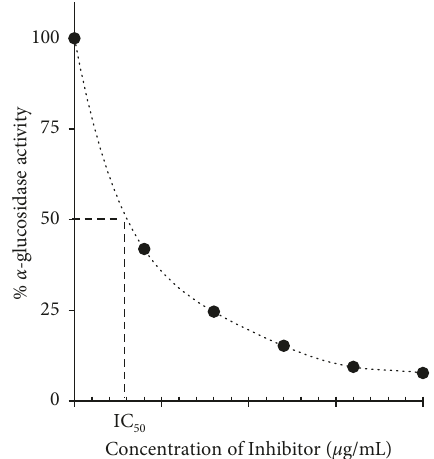
Figure 1: Determination of IC50 from a plot.